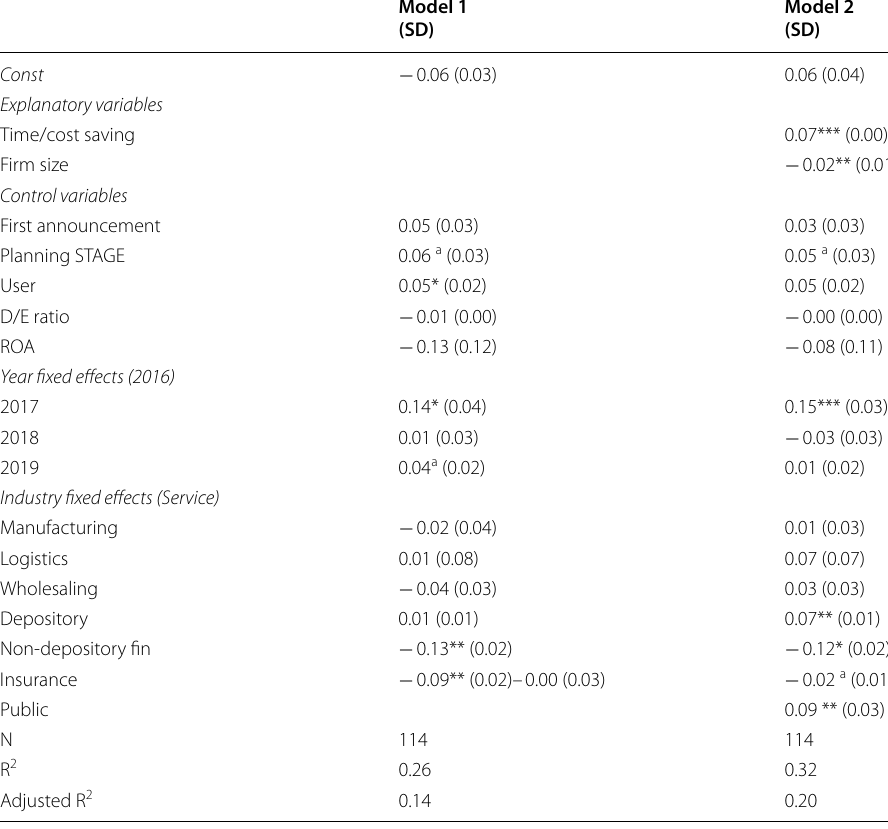
Table 16 Results of fixed effects regression